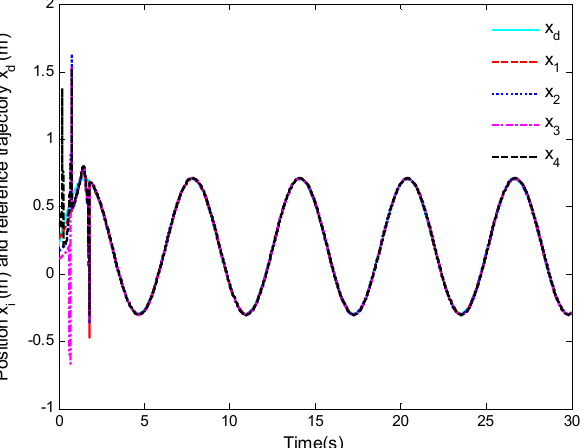
Figure 3. The curves of the agents' output x i and the reference trajectory x d .